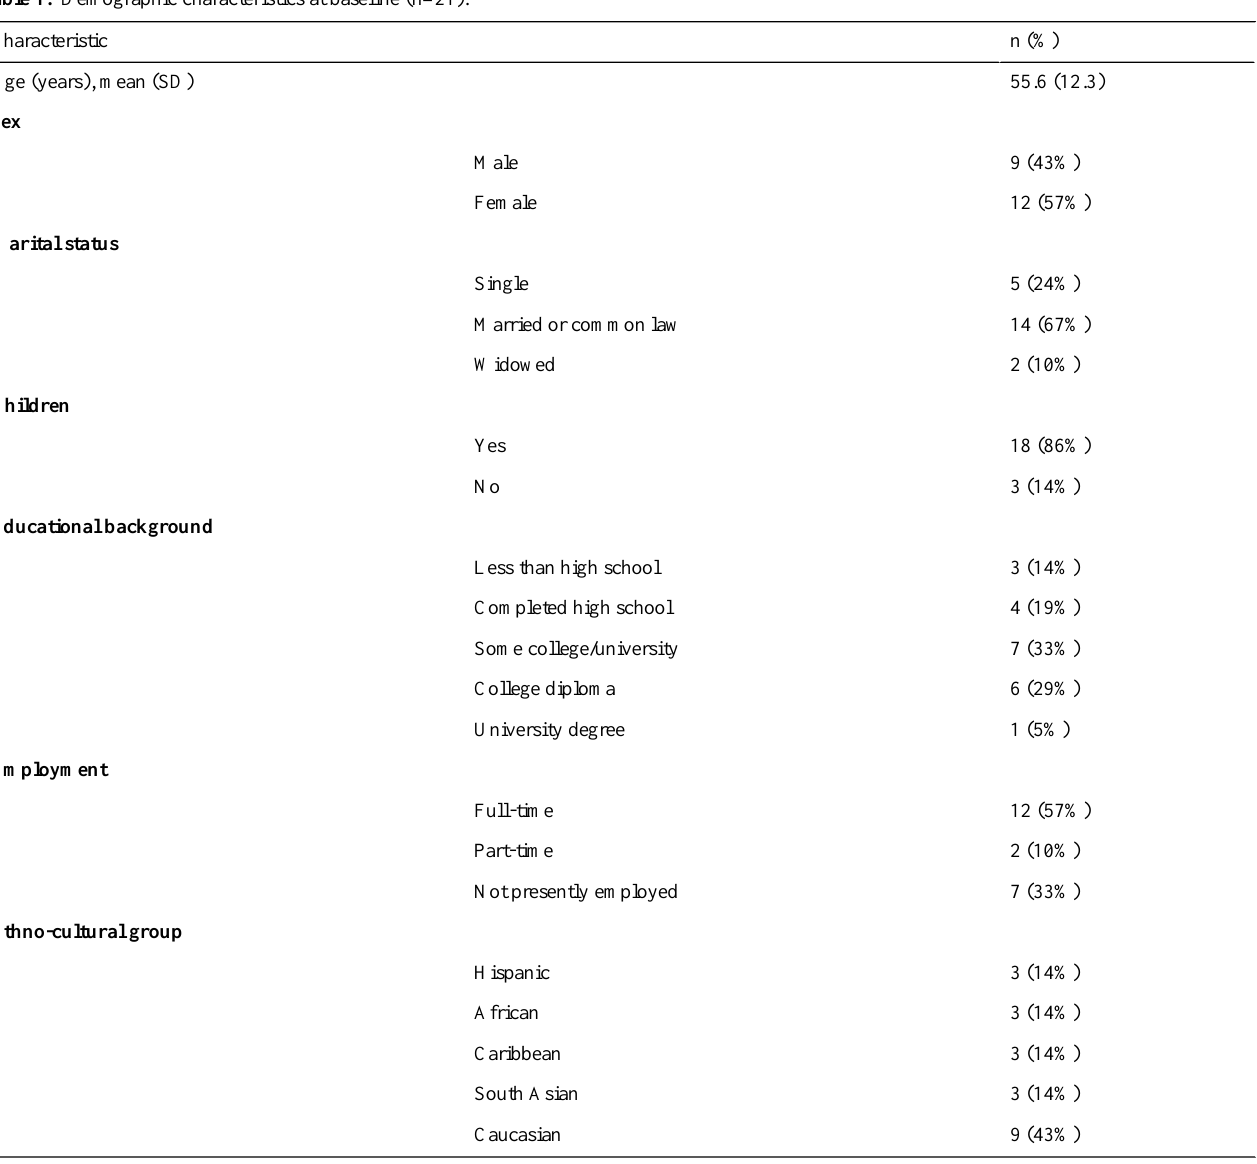
Table 1. Demographic characteristics at baseline